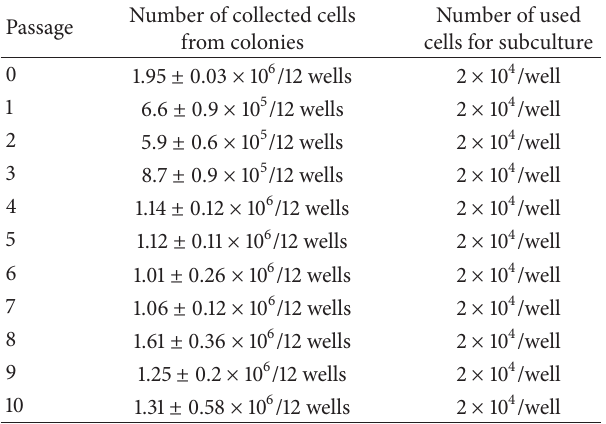
Table 1: Number of cells collected from colonies in subculture with fresh feeder